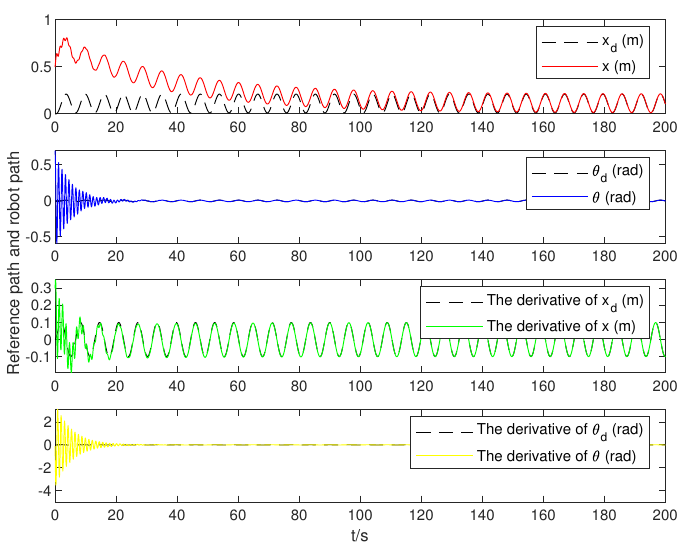
Figure 1. The displacement following paths.